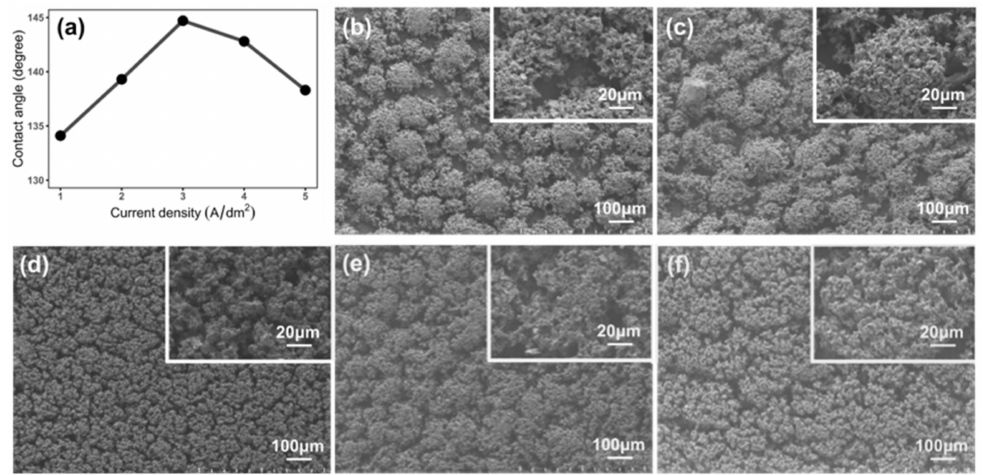
Figure 4. The WCA change trend ( a ) and SEM images ( b – f ) of the Ni-Co/WS 2 nanocomposite coatings prepared under different current densities: ( b ) 1 A/dm 2 ; ( c ) 2 A/dm 2 ; ( d ) 3 A/dm 2 ; ( e ) 4 A/dm 2 ; ( f ) 5 A/dm 2 .